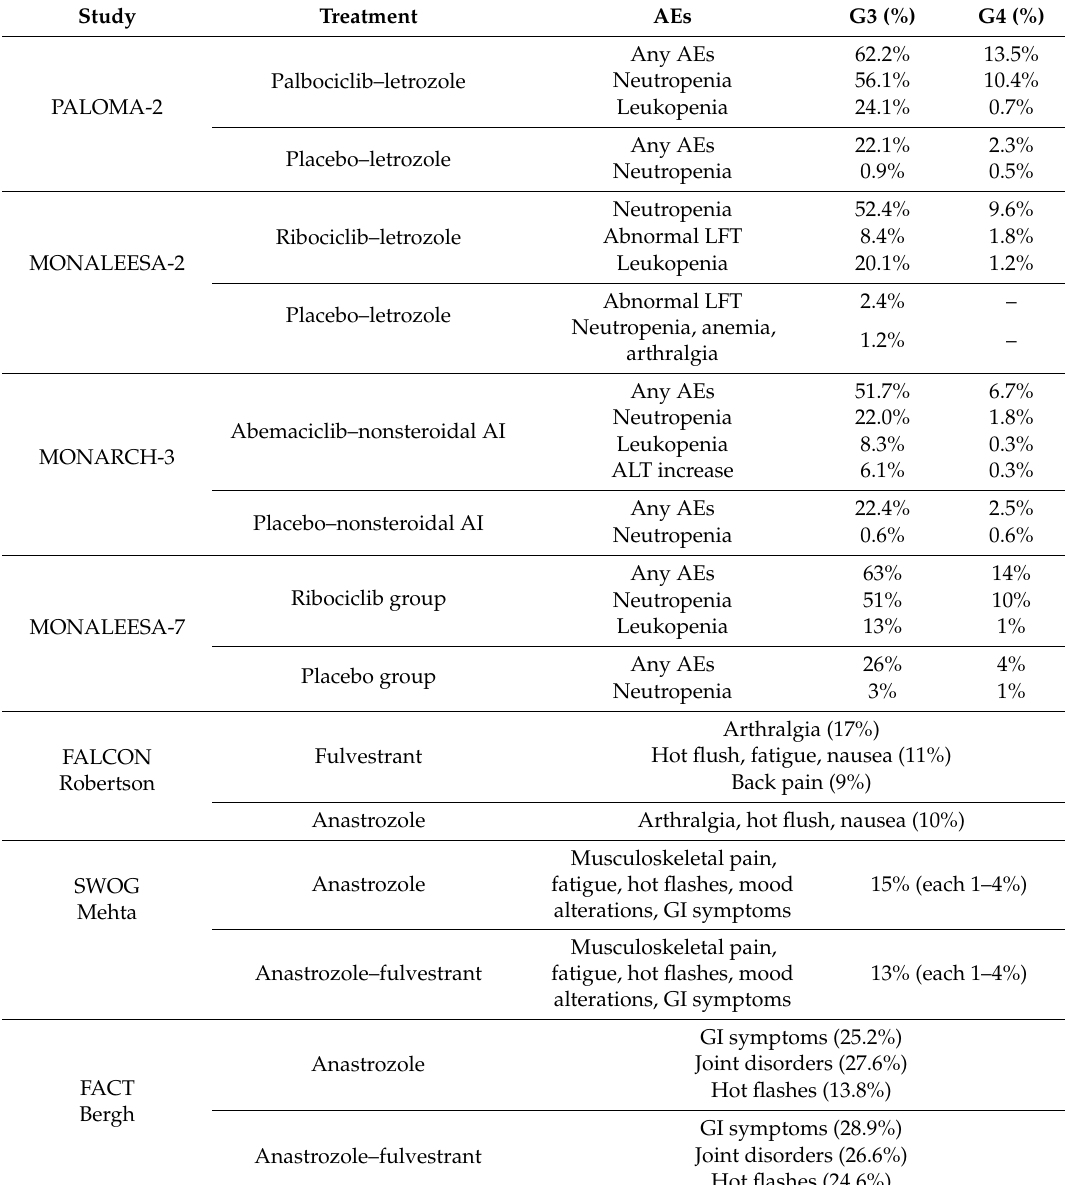
Table 2. Main adverse e ff ects registered in each